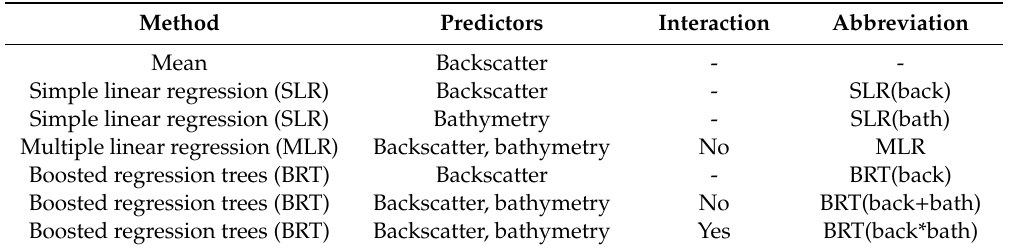
Table 1. Bulk shift methods tested.